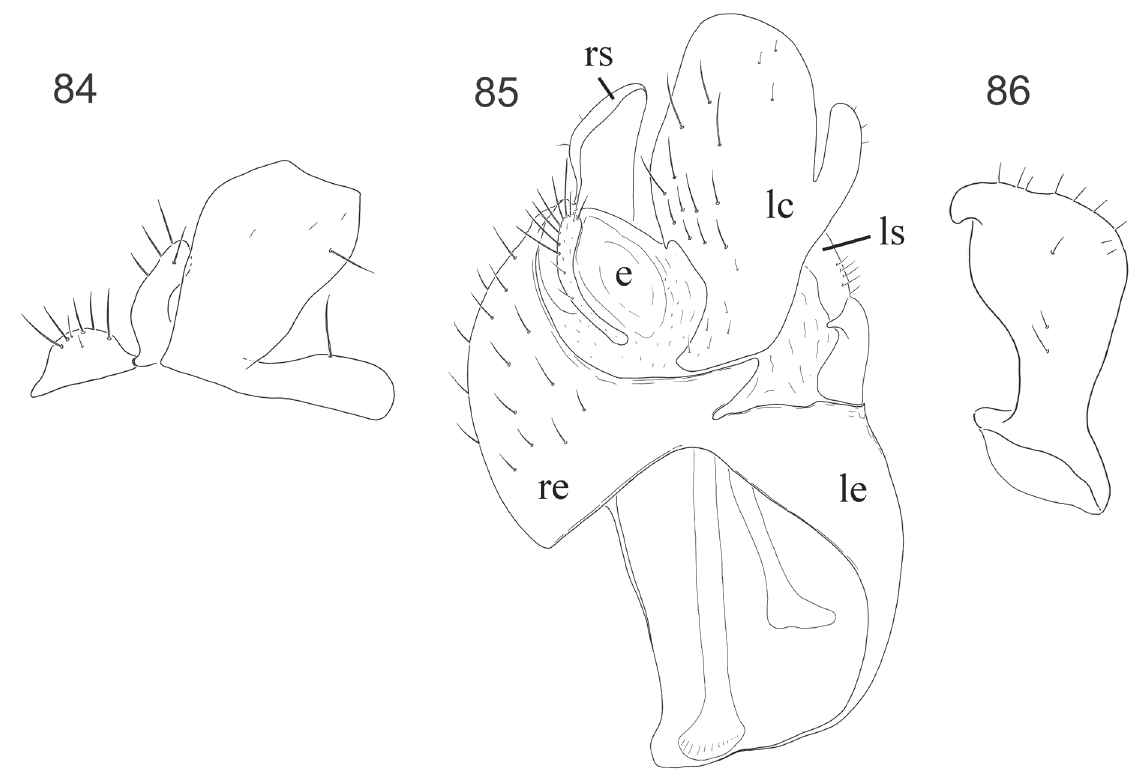
Figs 84-86. Crossopalpus temasek sp. nov., ♂ terminalia. 84 . right surstylus, dorsal view. 85 . epandrium and cerci. 86 . left surstylus, lateral